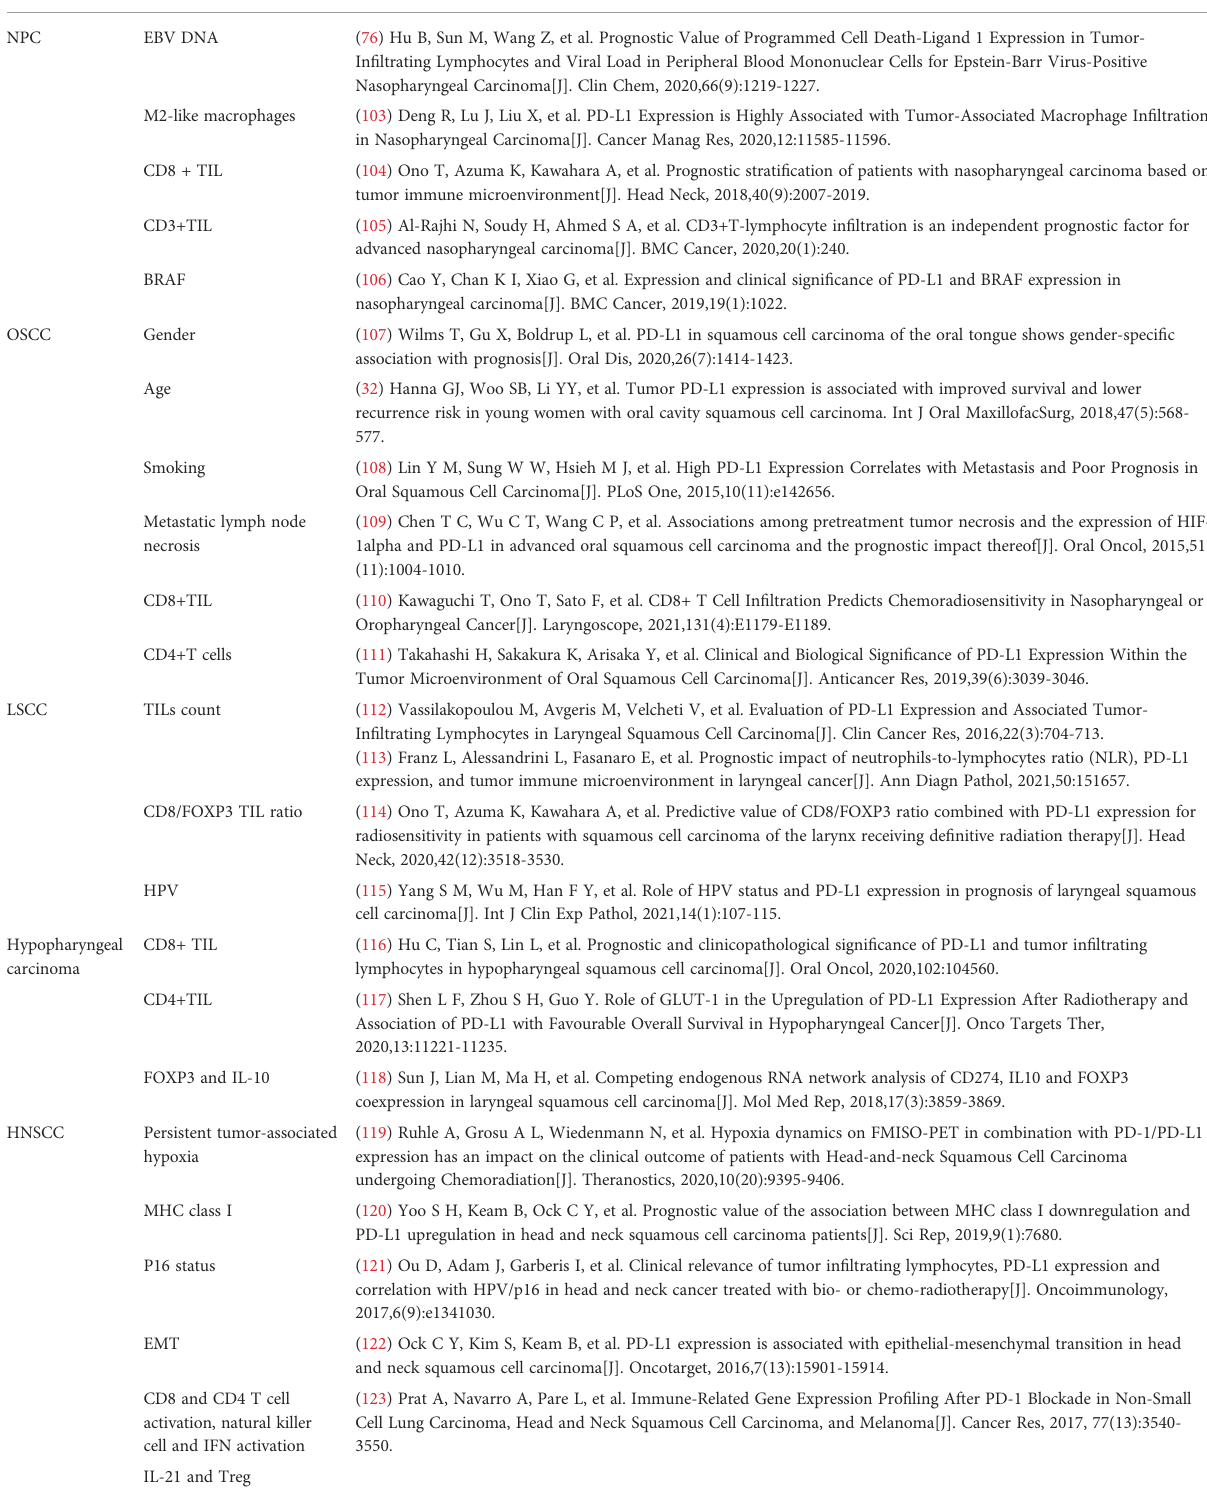
TABLE 1 Combination prognostic indicators for different